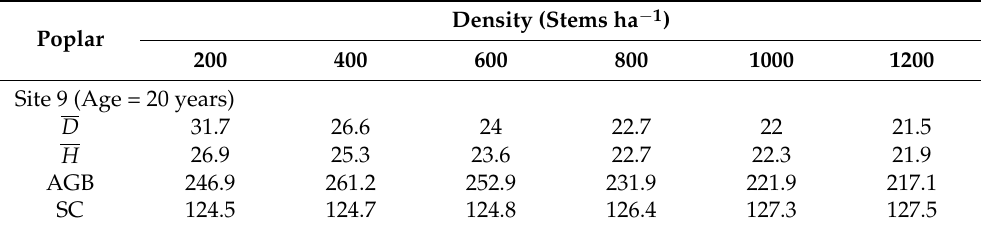
Table 4. Simulated effects of the planting density on the stand characteristics at a stand age of 20 years old using the modified